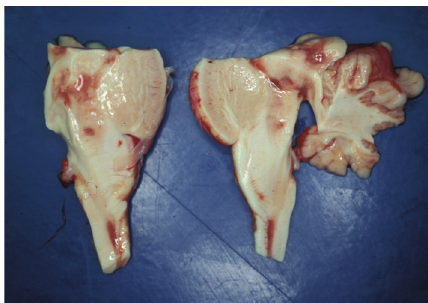
Figure 2: Cystic, reddish areas in mesencephalon, pons, and medulla oblongata.